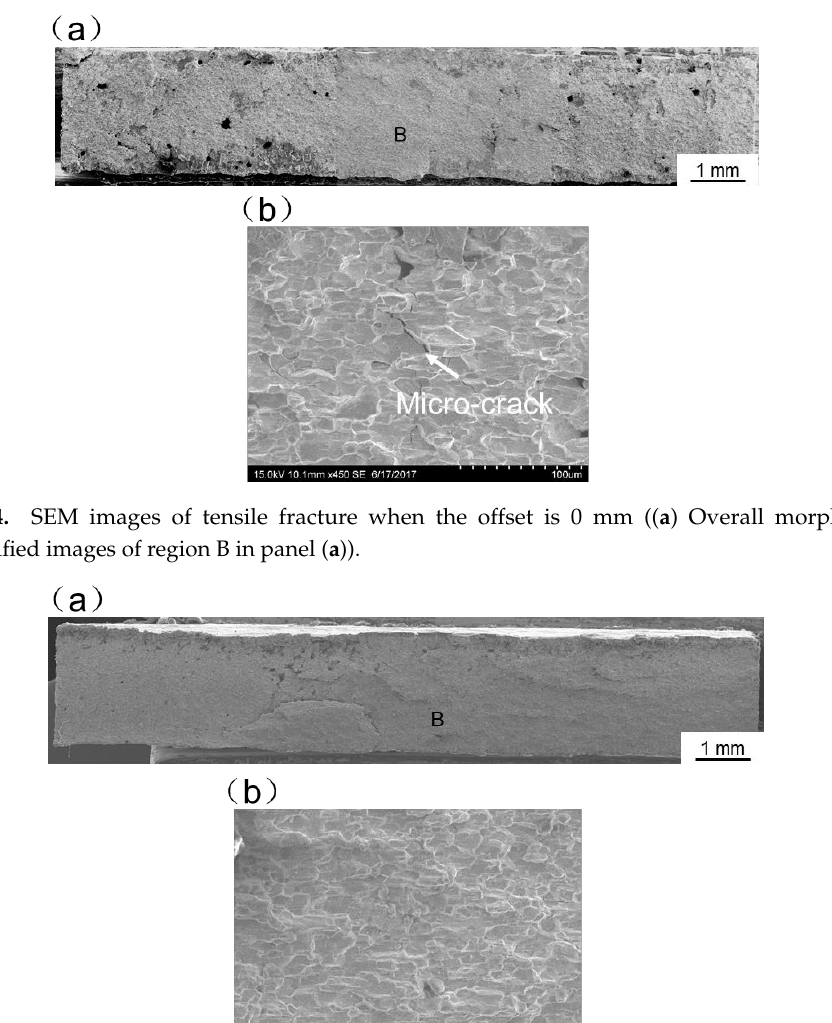
Figure 13. SEM images of tensile fracture when the offset is −0.25 mm (( a ) Overall morphology; ( b , c ) Magnified images of region B and C in panel ( a )).